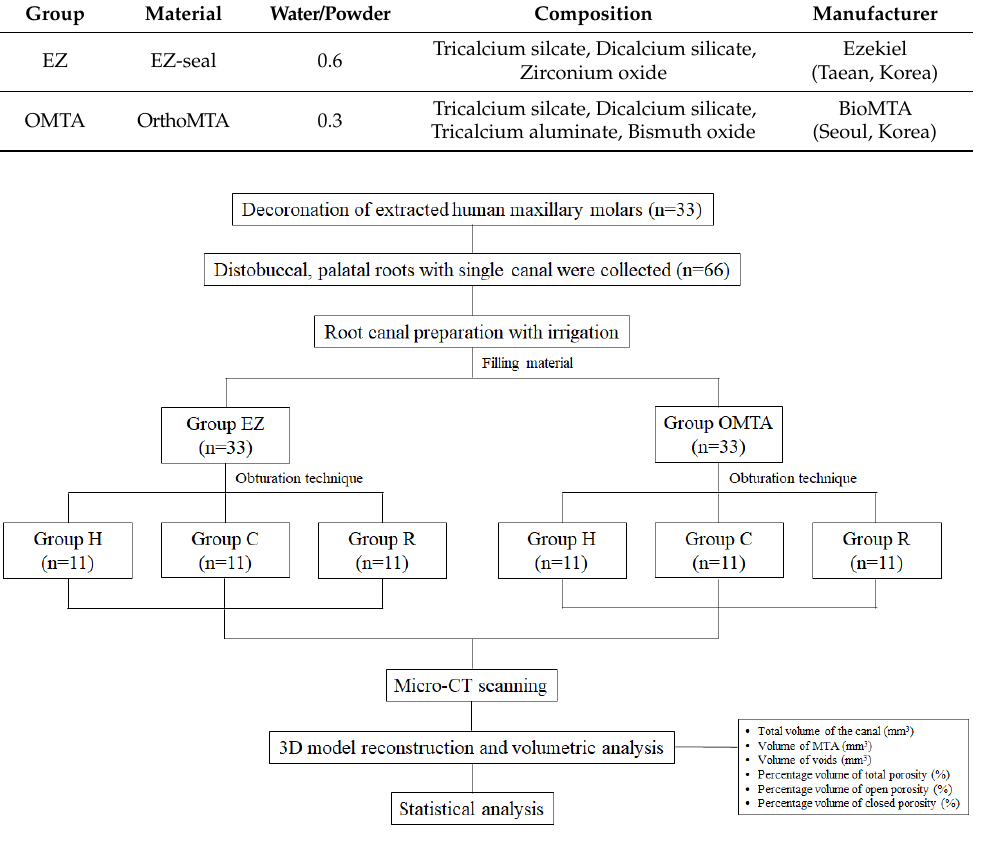
Figure 1. A flowchart of this study. EZ: EZ-Seal, OMTA: OrthoMTA, Group H: Hand condensation with S-Kondensor, Group C: Compactor activation + hand condensation with S-Kondensor, Group R: Reverse rotary motion of Ni-Ti file + hand condensation with S-Kondensor.